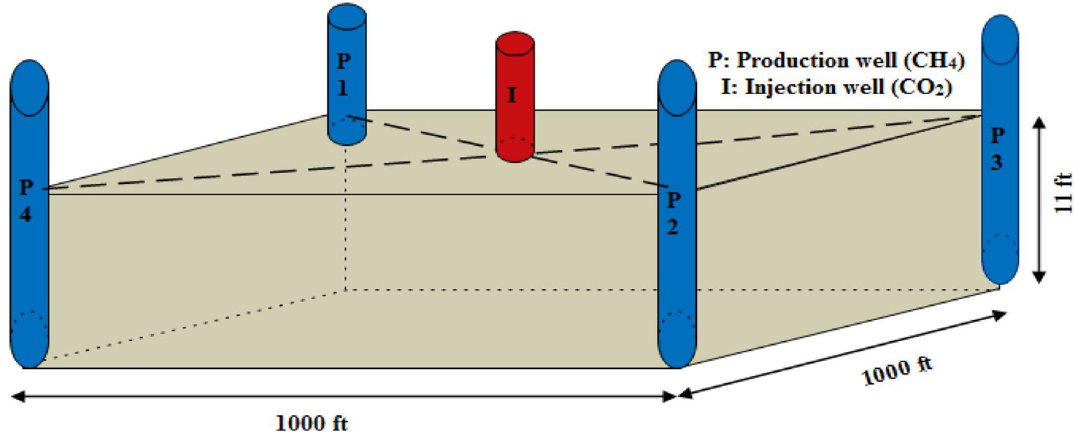
Figure 4. Coalbed block for CO 2 -ECBM